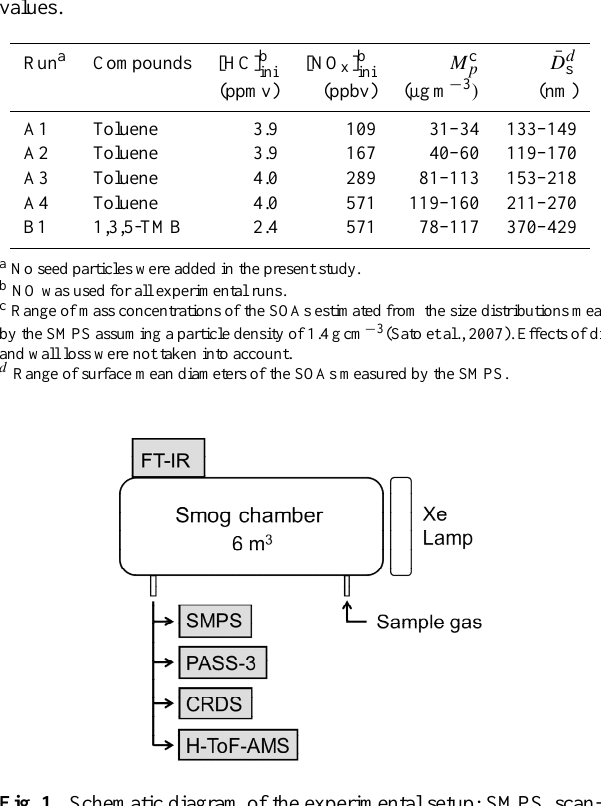
Fig. 1. Schematic diagram of the experimental setup; SMPS, scan- Figure 1. Schematic diagram of the experimental setup; SMPS, scanning mobility particle 835 ning mobility particle sizer; PASS-3, 3 λ -photoacoustic soot spec- sizer; PASS-3; 3 l -photoacoustic soot spectrometer; CRDS, cavity ring-down spectrometer; 836 trometer; CRDS, cavity ring-down spectrometer; FT-IR, Fourier FT-IR, Fourier transform-infrared spectrometer; H-ToF-AMS: high-resolution time-of-flight 837 transform-infrared spectrometer; H-ToF-AMS, high-resolution aerosol mass spectrometer. 838 time-of-flight aerosol mass spectrometer.